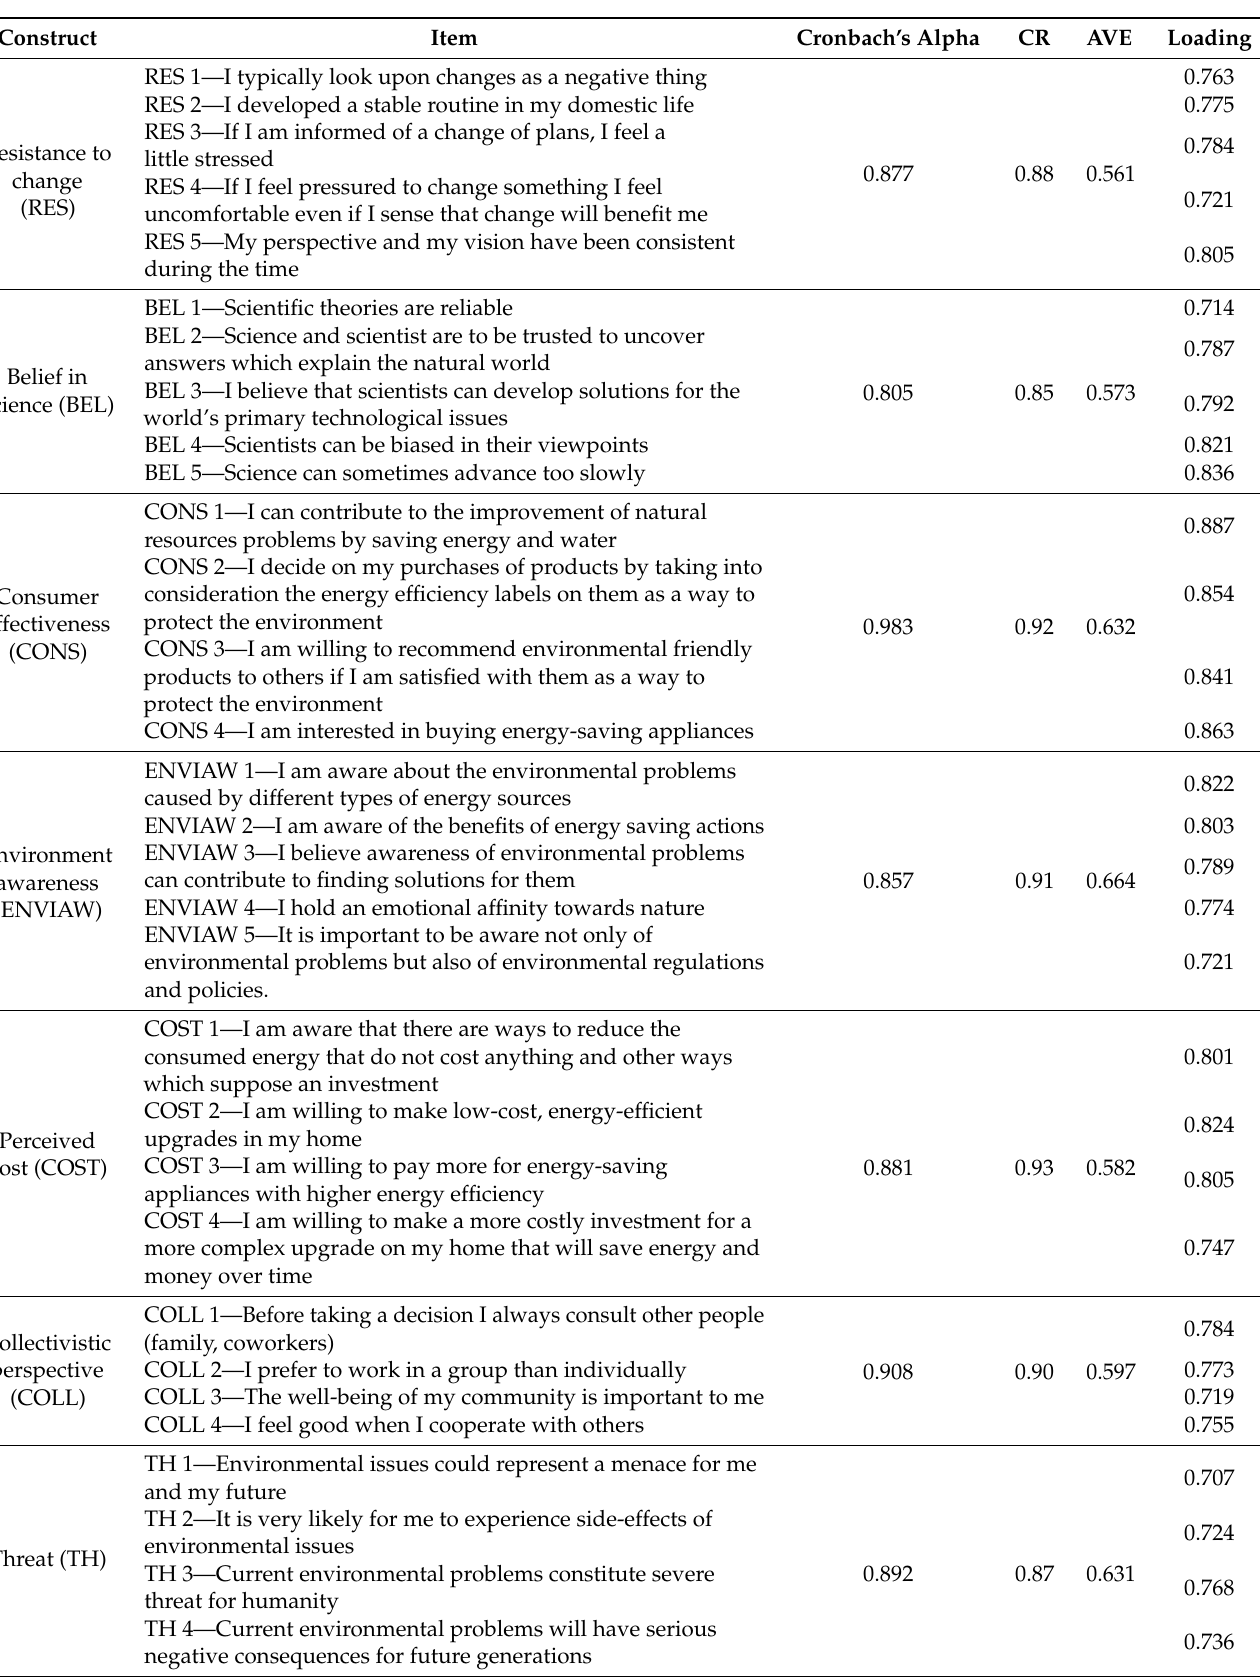
Table 2. Reliability and validity analysis of the